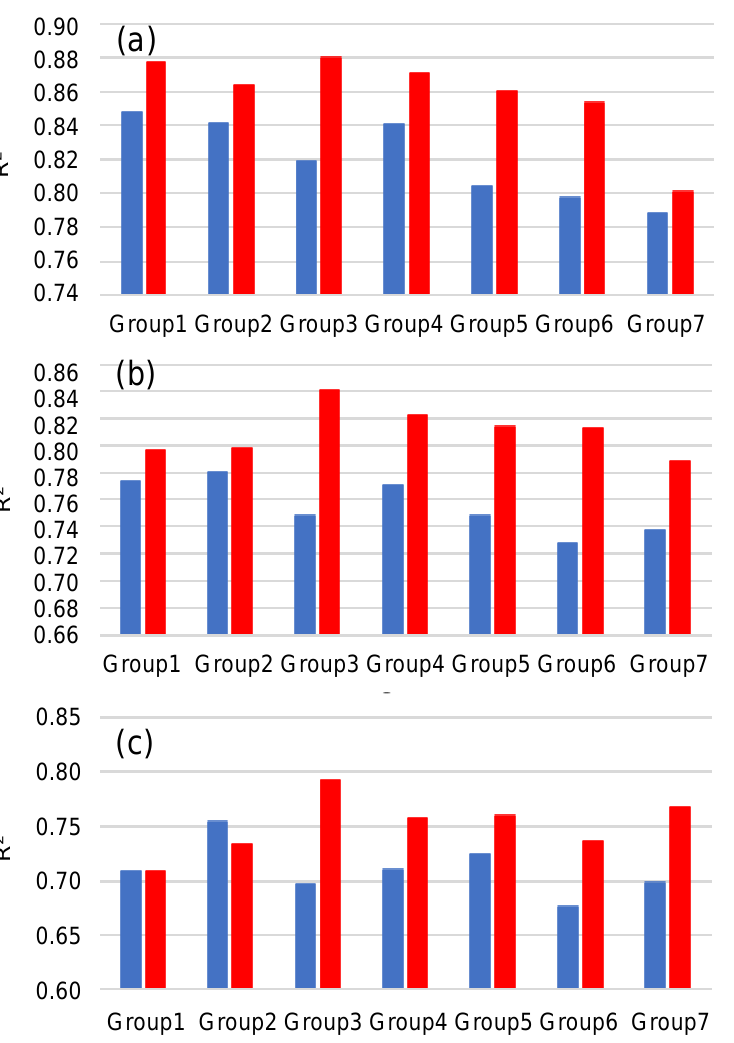
Figure 9. R 2 bar plot comparing VAR and ARIMA models for ( a ) 1 h, ( b ) 2 h, and ( c ) 3 h advance forecasting, respectively. Blue and red indicate error statistics obtained from the VAR and ARIMA forecasting model, respectively.